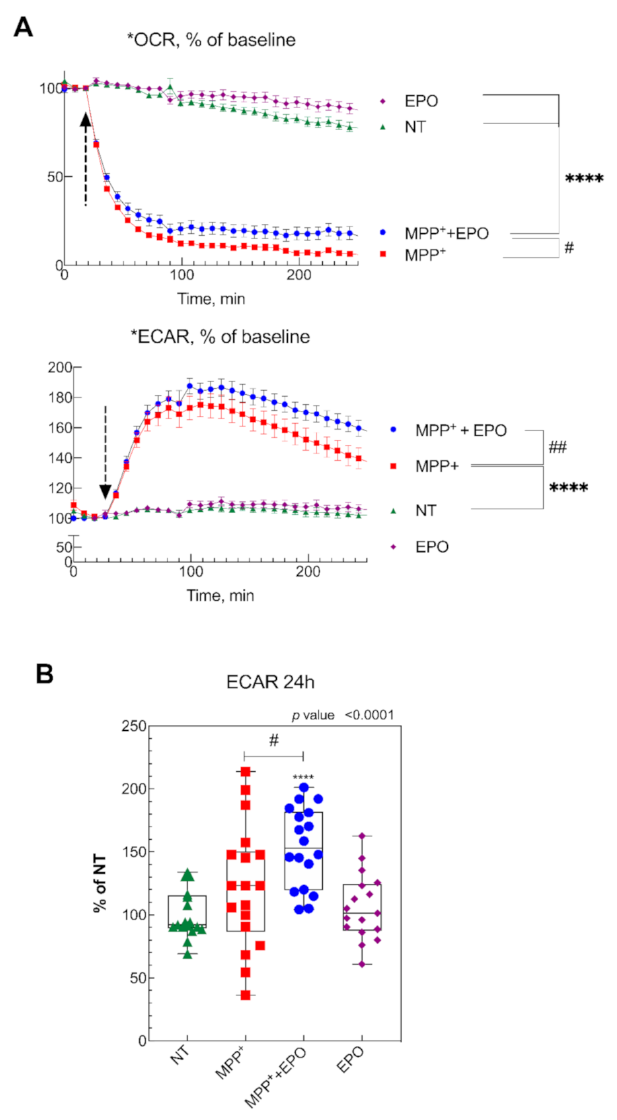
Figure 6. Effect of EPO on cell metabolism. ( A ) oxygen consumption rate (OCR) and extracellular acidification rate (ECAR) were measured in SH-SY5Y cells 200 min after injection of 500 µ M MPP + in the presence or absence of 4 U/mL EPO, or only SH-SY5Y treated with 4 U/mL. Data are represented as average of three independent experiments. **** p < 0.0001 vs. NT, # p < 0.05, ## p < 0.001 vs MPP + . ( B ) ECAR values of SH-SY5Y cells, non-treated (NT), after 24 h of treatment with MPP + , MPP + +EPO, or EPO-only. Data from 3 independent experiments per condition, normalized to the control baseline (**** p < 0.0001 vs. NT, # p < 0.05 vs. MPP +